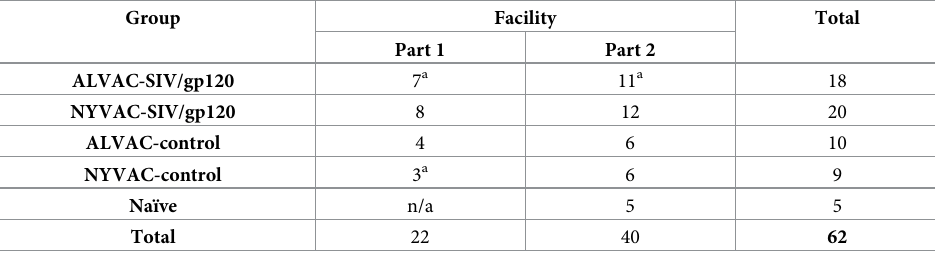
Table 1. Vaccination groups.